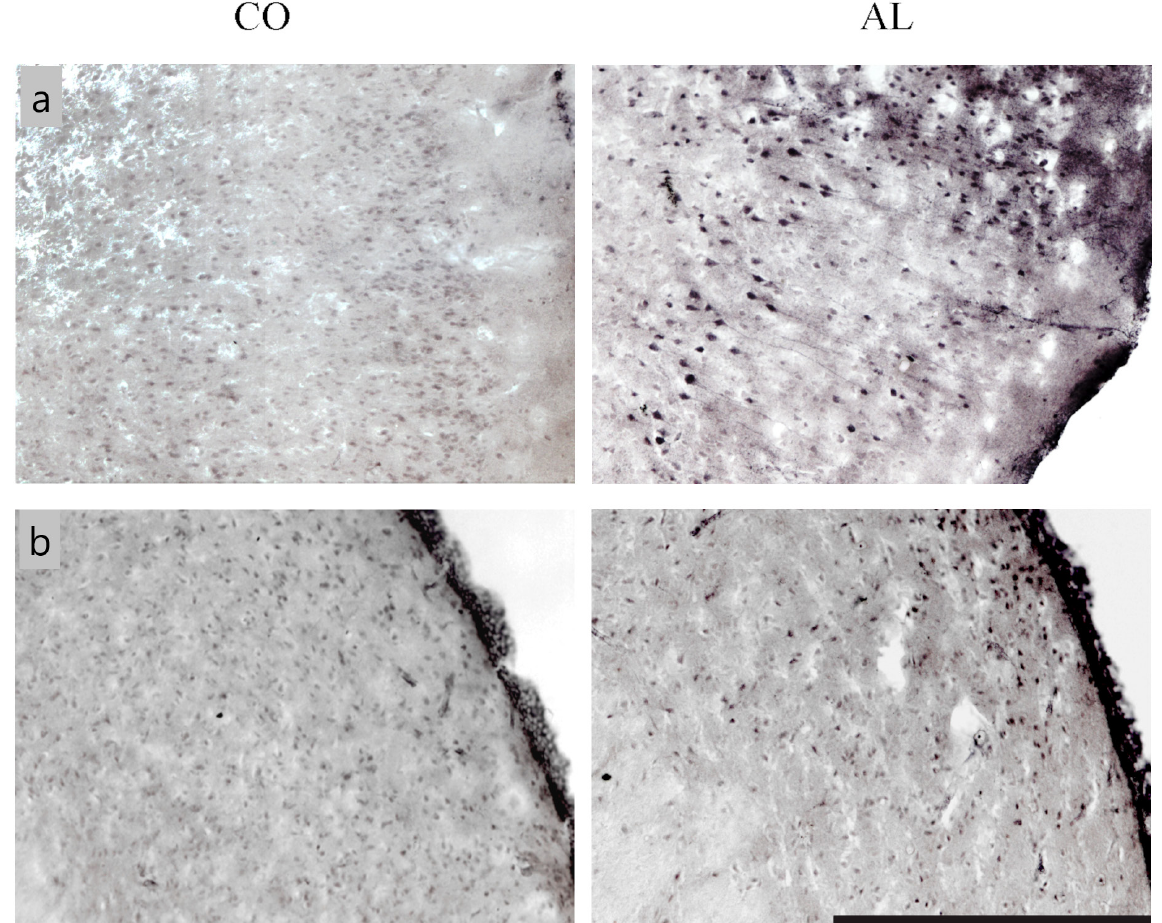
Figure 3. CRF immunoreactive cells (black coloring) in the following areas: (a) anterior cingulate cortex, (b) dorsolateral Septum, from animals in the following groups: Control (CO), and Alcohol (AL). Magnification: 200x.; Scale bar: 300